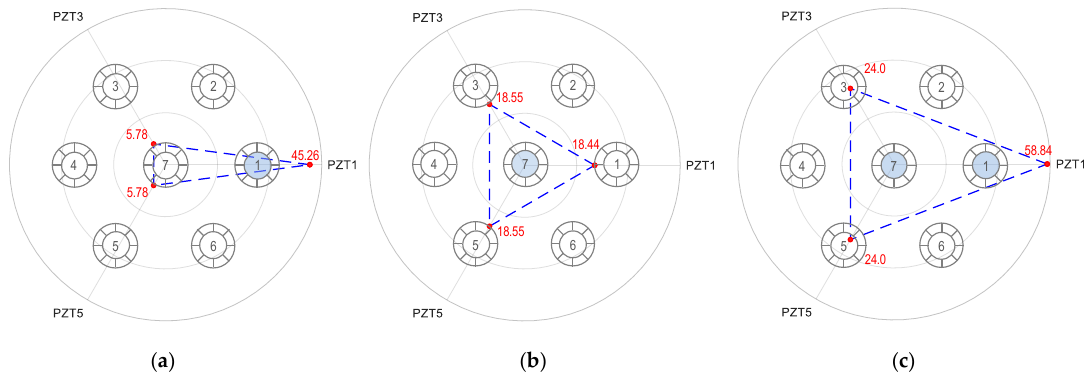
Figure 17. Linear tomography of RMSD indices (%) using PZTs 1, 3 and 5: Peak 1’s impedance. ( a ) Strand 1 breakage, ( b ) Strand 7 breakage, and ( c ) Strands 1 and 7 breakage.